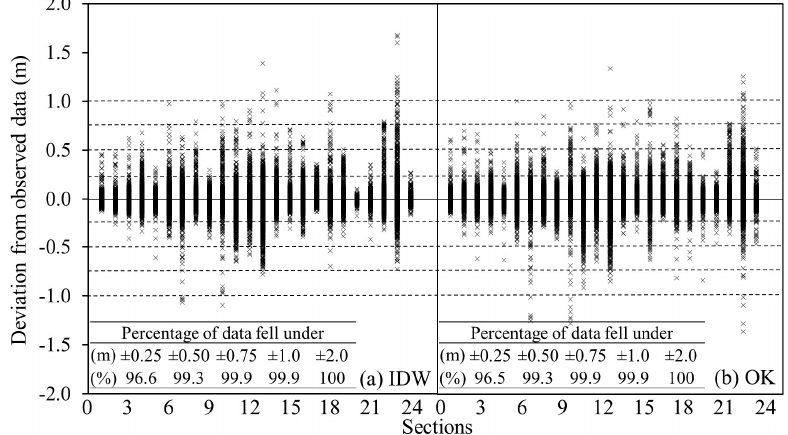
Figure 6. Deviation of the predicted values from the observed data for both ( a ) IDW and ( b ) OK methods in selected 24 sections. Figure 5. Comparison of the observed and predicted elevation values using both ( a ) IDW and ( b ) OK methods in selected 24 sections.